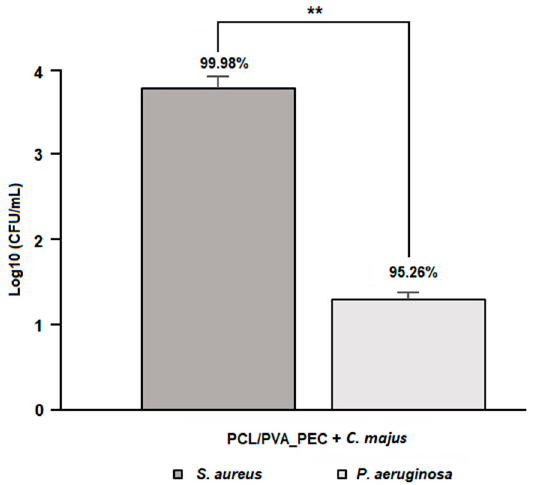
Figure 5. Assessment of antibacterial properties of the produced C. majus -loaded electrospun PCL/PVA_PEC nanofibrous meshes against S. aureus and P. aeruginosa . (Data are presented as the mean ± SD, ** p < 0.01).